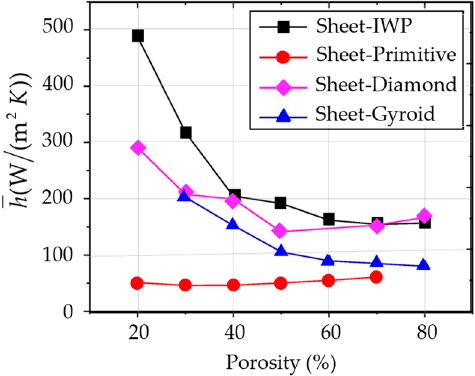
Figure 12. Effect of porosity on convective heat transfer coefficient for different sheet-TPMS structures at Re = 40 [58].